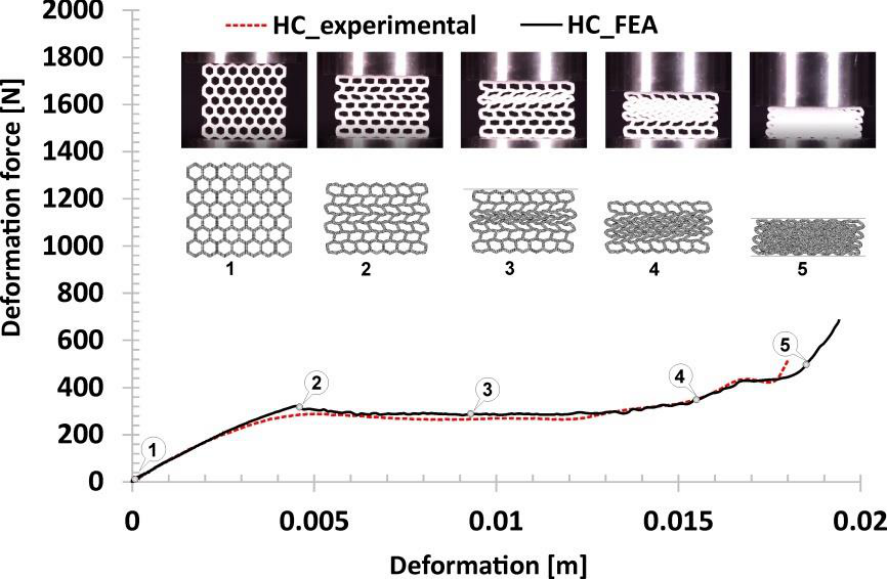
Figure 22. The results of the honeycomb compression tests obtained based on the FE analysis.